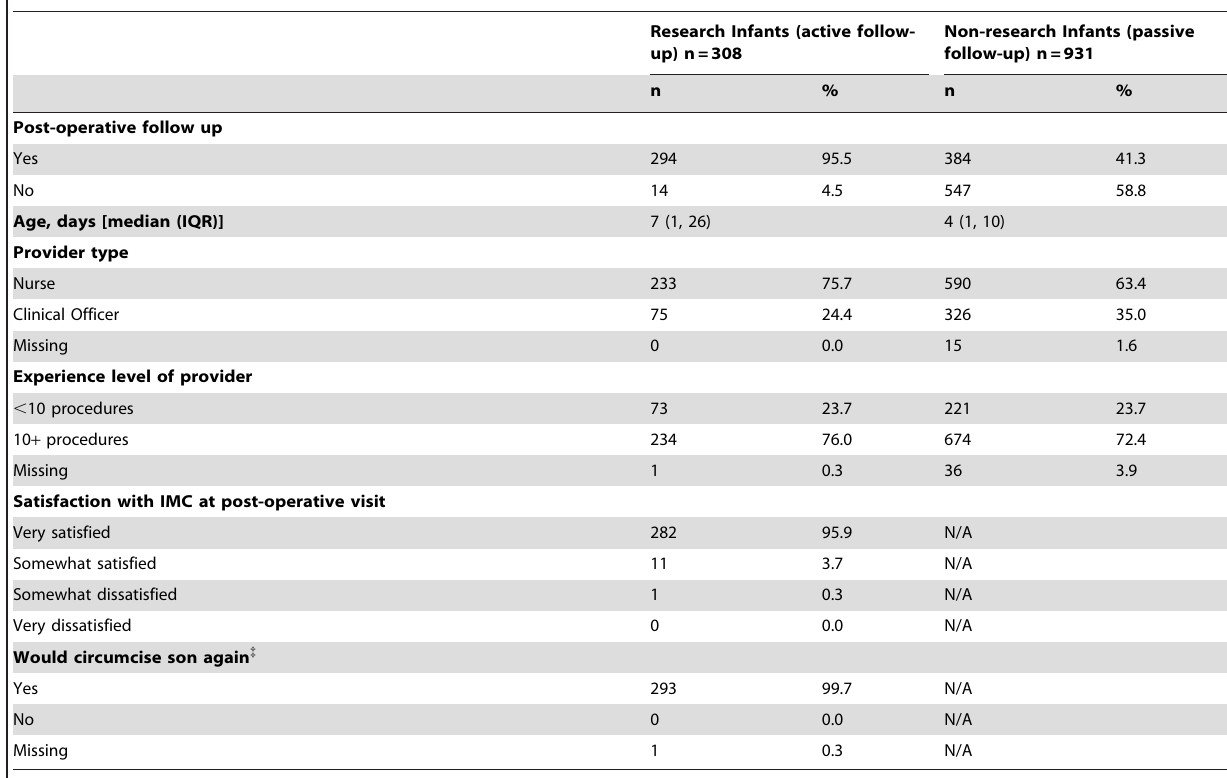
Table 1. Characteristics of research and non-research IMC procedures.